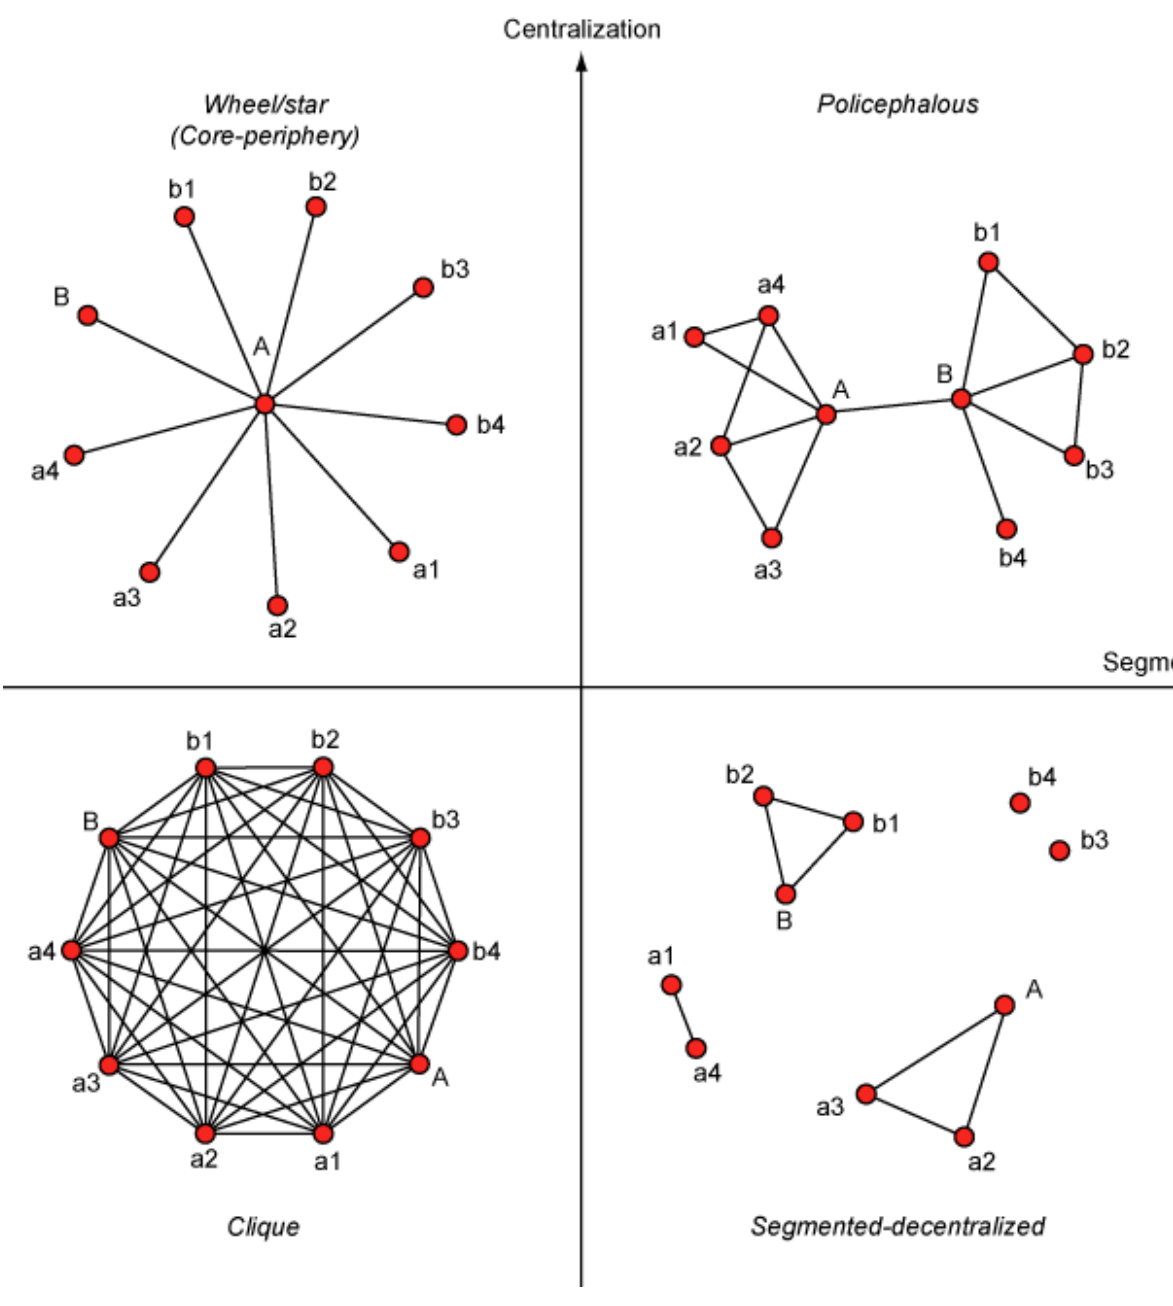
Fig. 1. The figure shows four idealized network models for social movements (Diani 2003a:306ff). These arise from different levels of centralization and segmentation in the network, and are described in the main text. Nodes are actors and links are resource exchanges of some kind. Note that all actors in social movements have mutually recognized each other as part of the same movement. Figure adapted from Diani